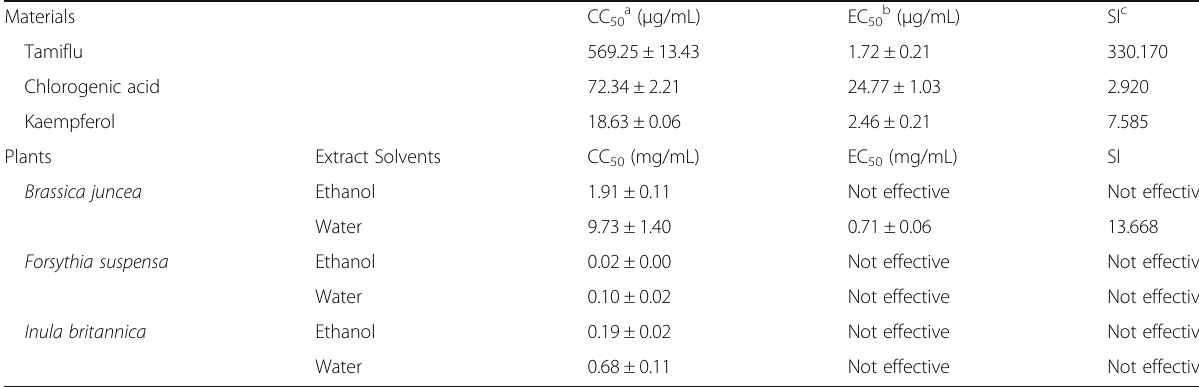
Table 4 Cytotoxicity, antiviral effect, and selectivity index of medicinal herb extracts Materials